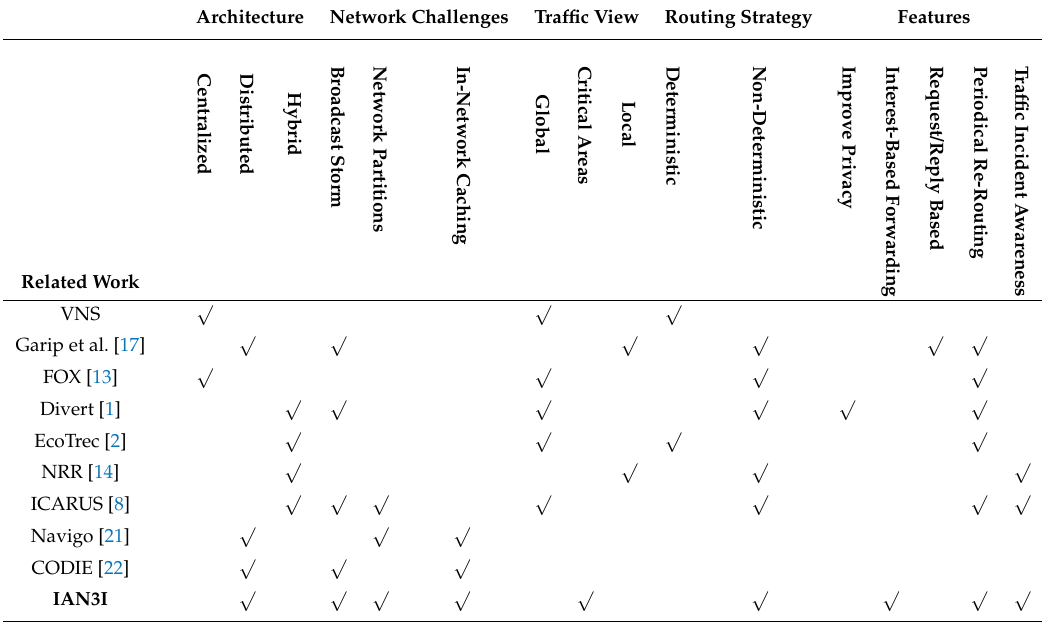
Table 1. Qualitative comparison of I am not interested in it (IAN3I) with literature